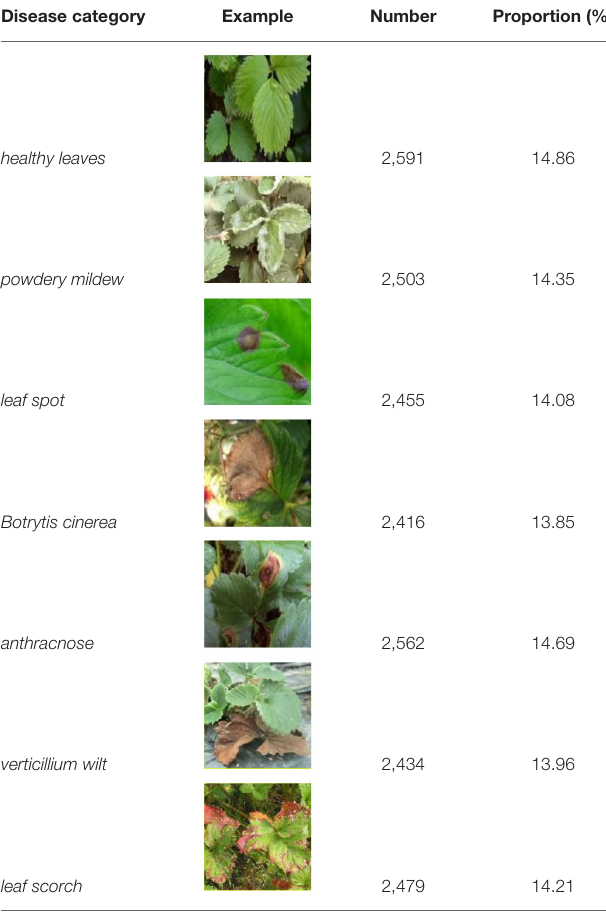
TABLE 1 | Quantitative distribution of seven strawberry leaf